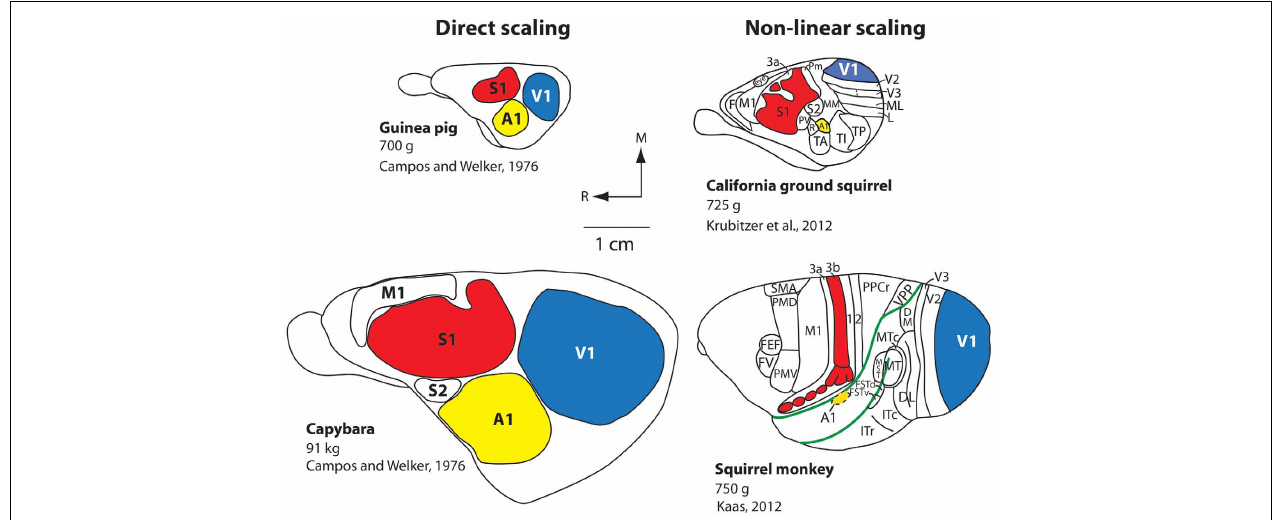
FIGURE 2 | Scaling of the neocortex in different mammals. Comparative studies demonstrate that the neocortex scales linearly or non-linearly. Capybaras can weigh up to 91kg and have an enlarged brain and neocortex compared to the closely related guinea pig, which weighs 700g. The more distantly related California ground squirrel has a similar body size to that of the guinea pig, but the scaling of the cortical sheet and cortical fields compared to the capybara is non-linear, and there is an increase in the number of cortical fields. An extreme example of a non-linear increase in the size of the cortical sheet is observed in squirrel monkeys. Although squirrel monkeys are of a similar weight (750g) compared to the guinea pig and